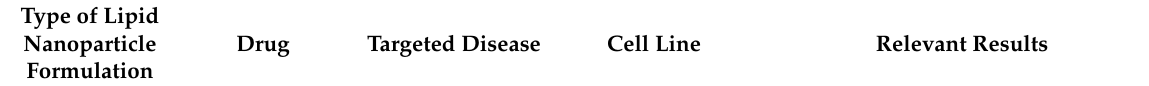
Table 2. Relevant outcomes from in vitro studies with nasal formulations of solid lipid nanoparticles (SLN) and nanostruc- tured lipid carriers